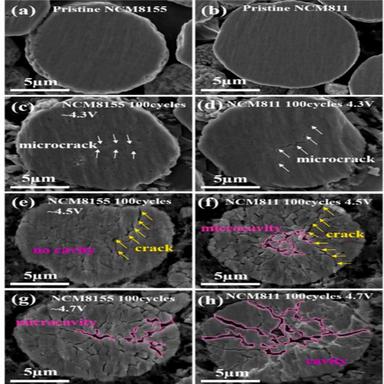
Cross-section SEM images of the of NCM8155 and NCM811 fresh materials and the materials after 100 cycles in the voltage windows of 2.7–4.3 V, 2.7–4.5 V, and 2.7–4.7 V, respectively.